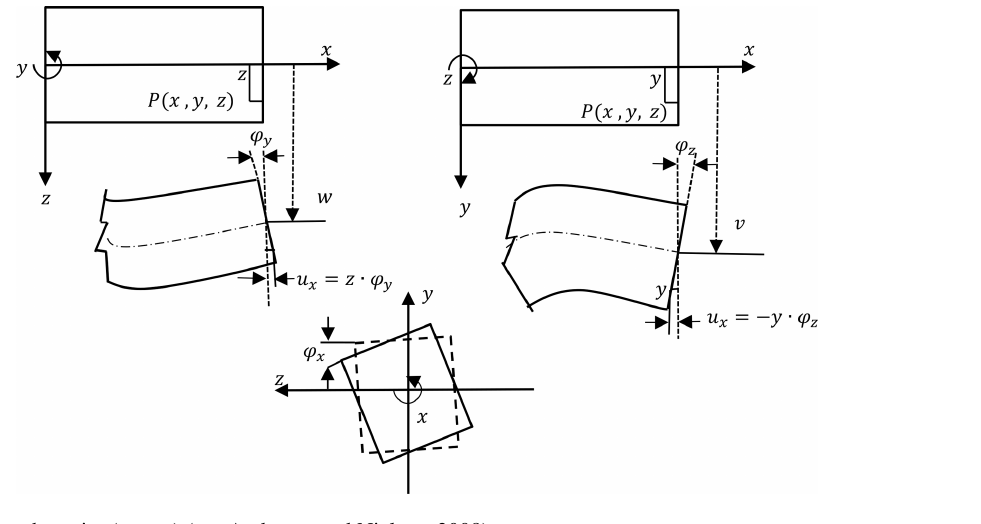
Figure 1. Deformation at the point ( x,y,z ) (see Andersen and Nielsen,